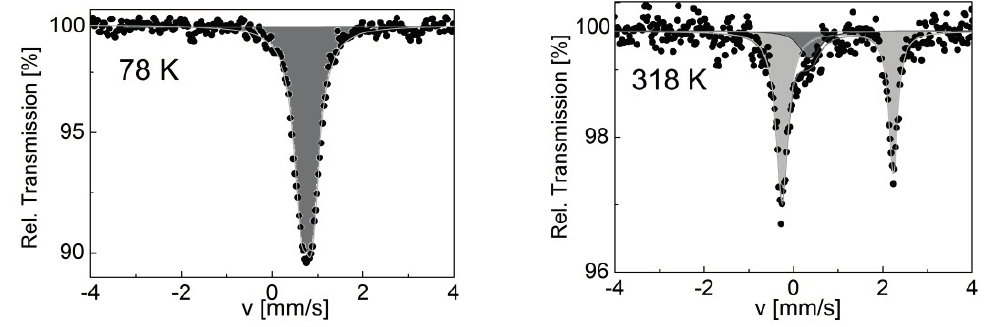
Figure 4. 57 Fe Mössbauer spectra for [Fe(hyetrz) 3 ]I 2 ·I 2 O at 78 K ( left ) and 318 K ( right